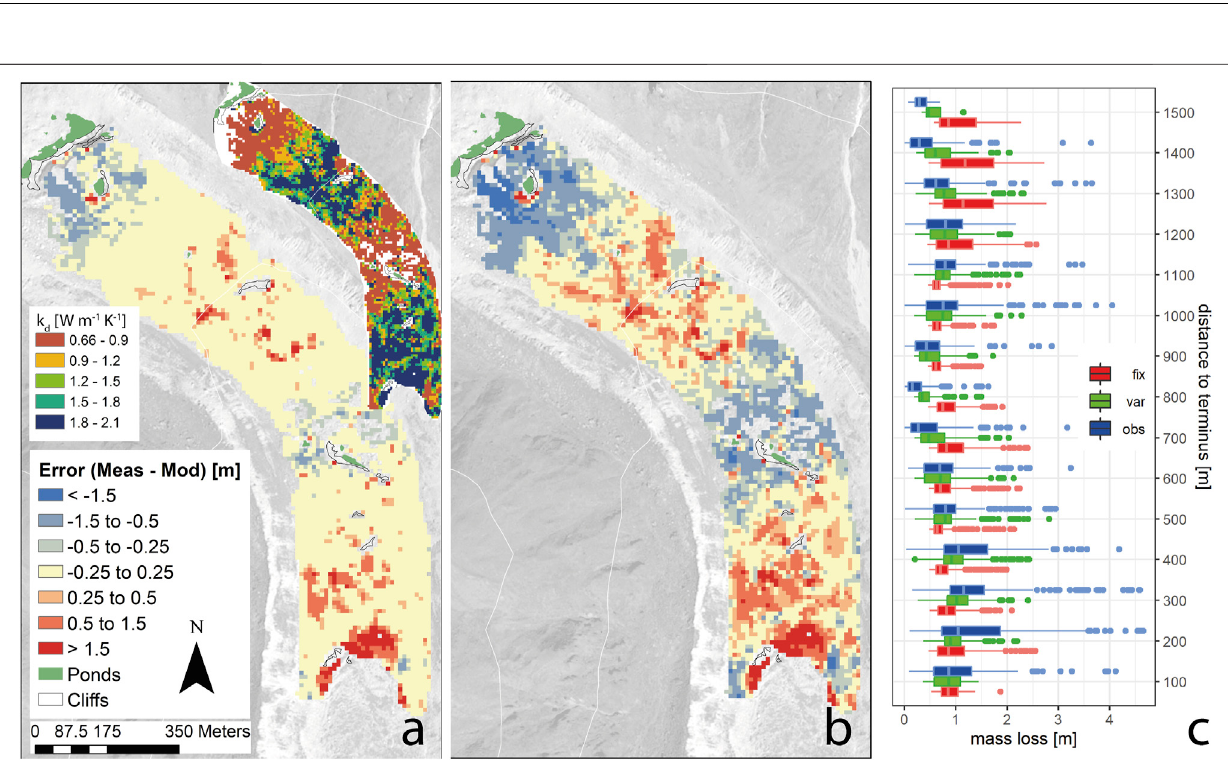
Frontiers in Earth Science |